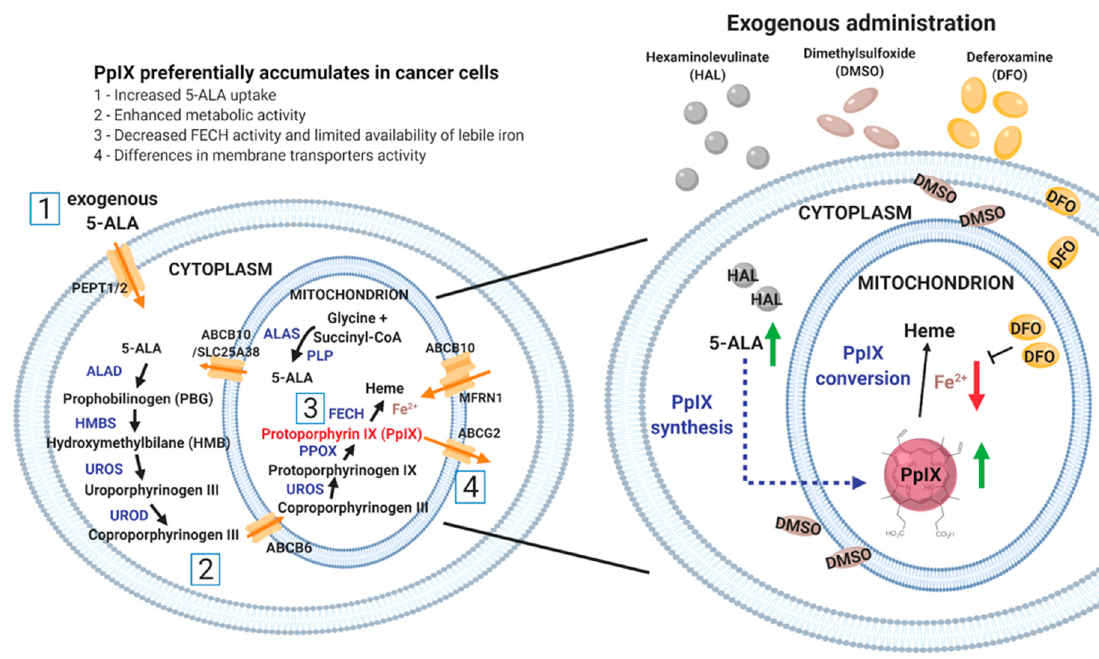
Figure 1. Schematic diagram of the heme biosynthesis pathway (left) and the principle of HAL mediated PpIX production enhancement with dimethylsulphoxide (DMSO) or deferoxamine mesylate salt (DFO) (right). DMSO favours the formation of pores in the cell and mitochondrion membranes, which increase the uptake of hexaminolevulinate 5-aminolevulinic acid (HAL (5-ALA)) and in turn boosts intracellular protoporphyrin IX (PpIX) synthesis (green arrow). In contrast, DFO inhibits the conversion of PpIX to heme by chelating iron (red arrow). The administration of both prodrugs attempts to enhance PpIX accumulation. The number [1 to 4] corresponds to the factors why preferentially accumulates in cancer cells when compared with normal